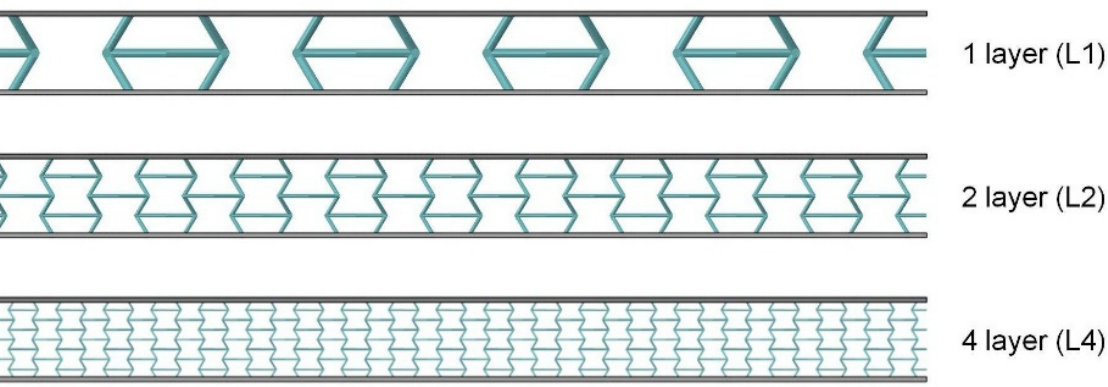
Figure 9. Three-dimensional lattice cores in single- and multi-layer configurations (side view in Figure 9. Three ‐ dimensional lattice cores in single ‐ and multi ‐ layer configurations (side view in parallel parallel projection).